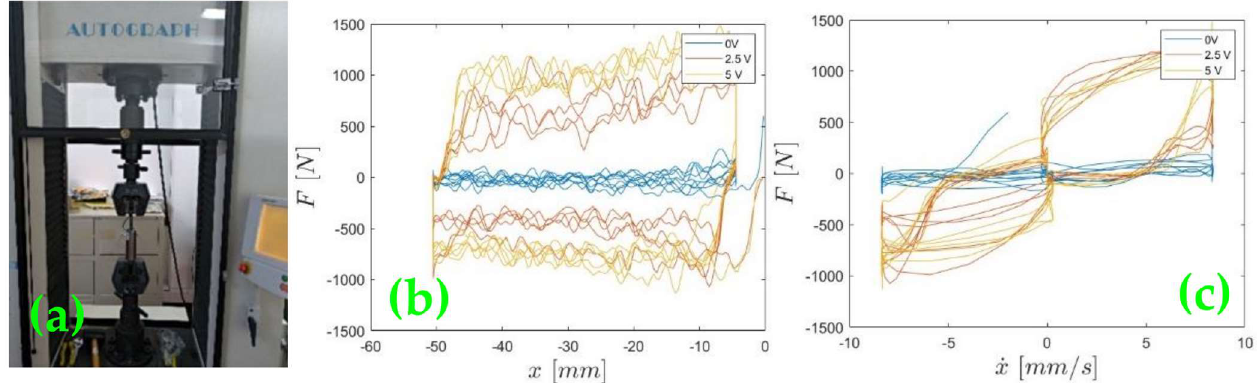
Figure 4. Results of the mechanical tests of the magnetorheological damper: ( a ) test setup; ( b ) force– displacement plot; ( c ) force-velocity plot.